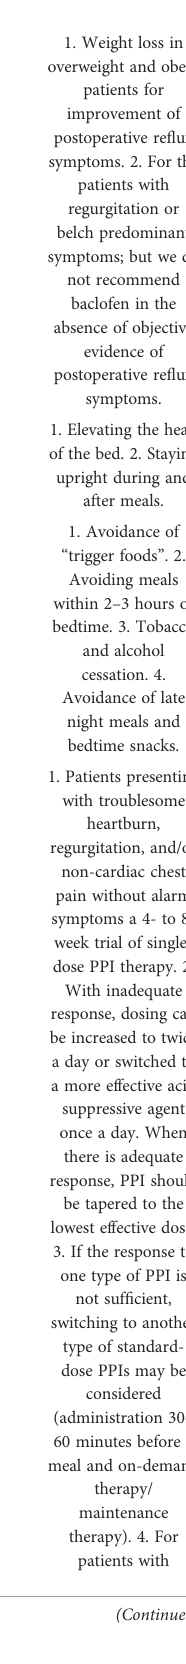
TABLE 4 The control steps of postoperative re fl ux